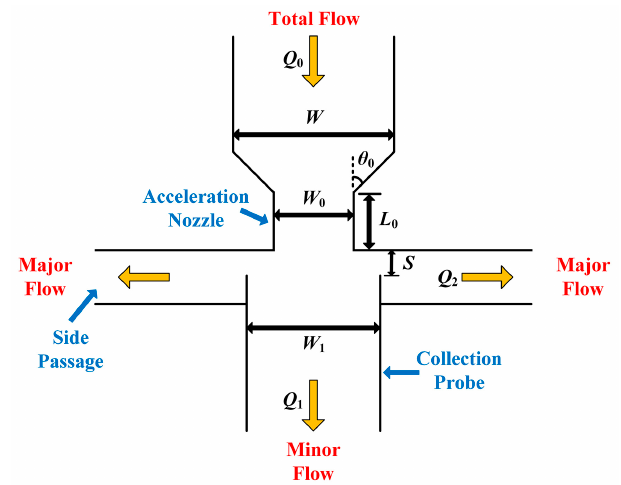
Figure 3. Cross-sectional view of the virtual impactor.